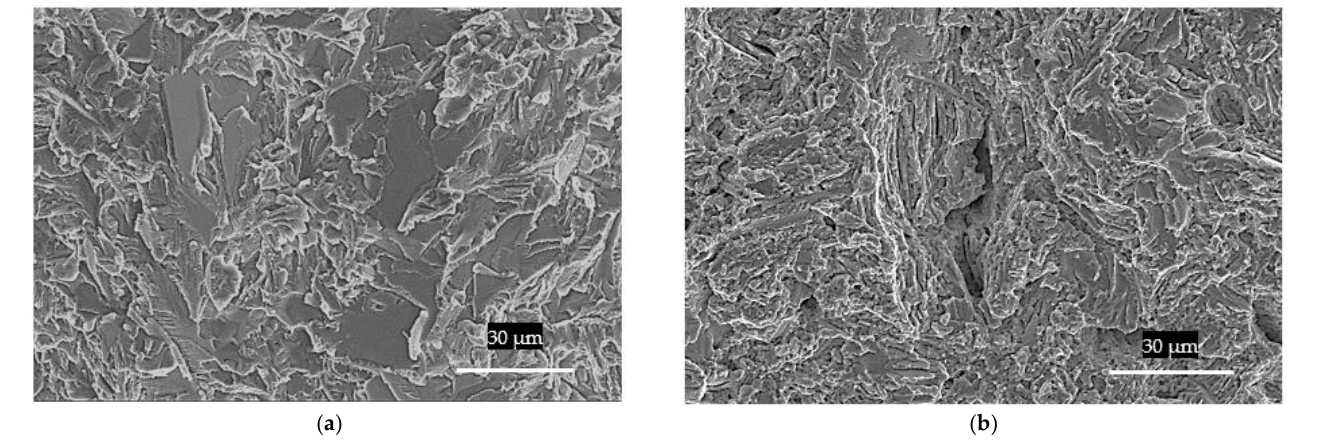
Figure 8. SEM; ( a ) TNM-0.8B-HIP tensile test fracture at room temperature, ( b ) TNM-0.8B-HIP post-creep fracture (750 °C, 250 MPa).